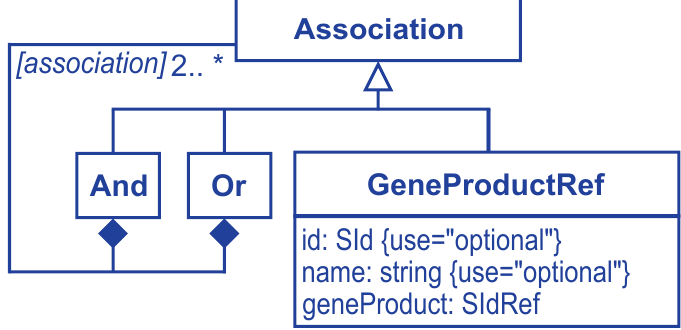
Figure 9: A UML representation of the Flux Balance Constraints package Association and derived classes. The [as- sociation] element name is the name of the class, de-capitalized. In this case, the possible values are "and", "or",